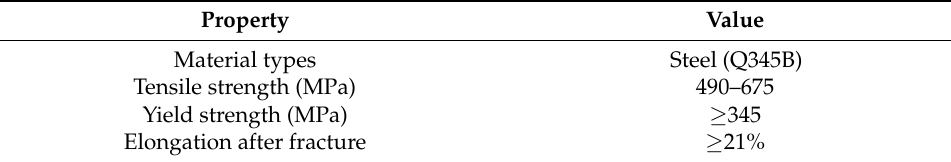
Table 1. Mechanical properties of specimens.